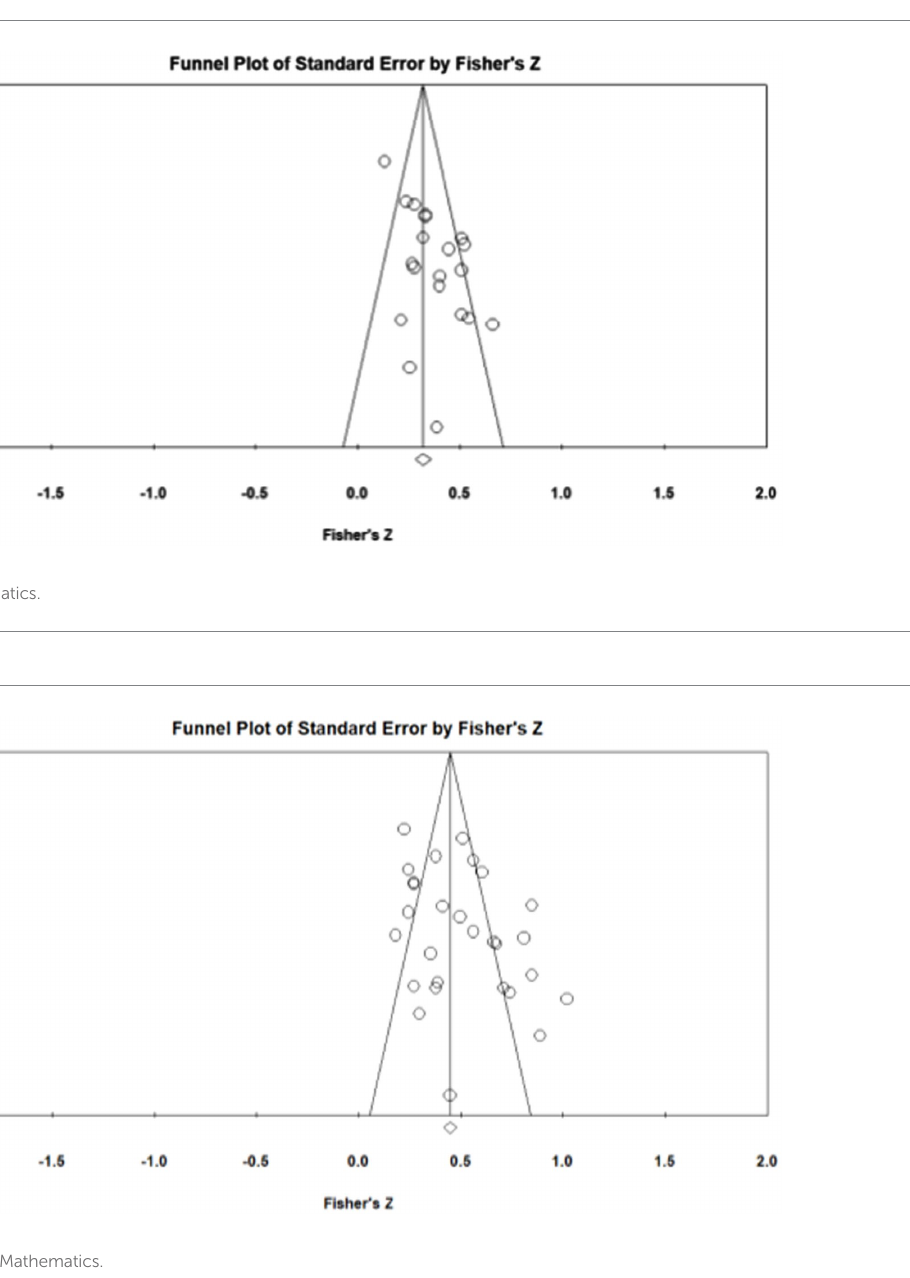
FIGURE 4 Funnel plot. Working